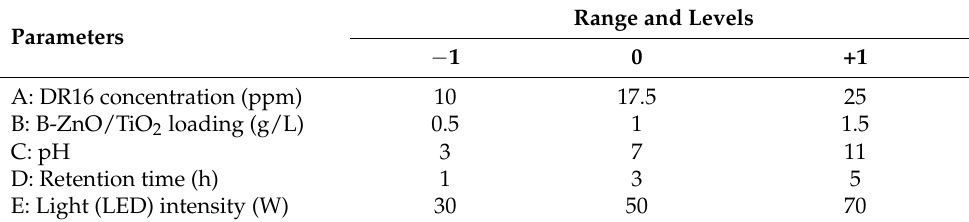
Table 1. Range and levels of the experimental